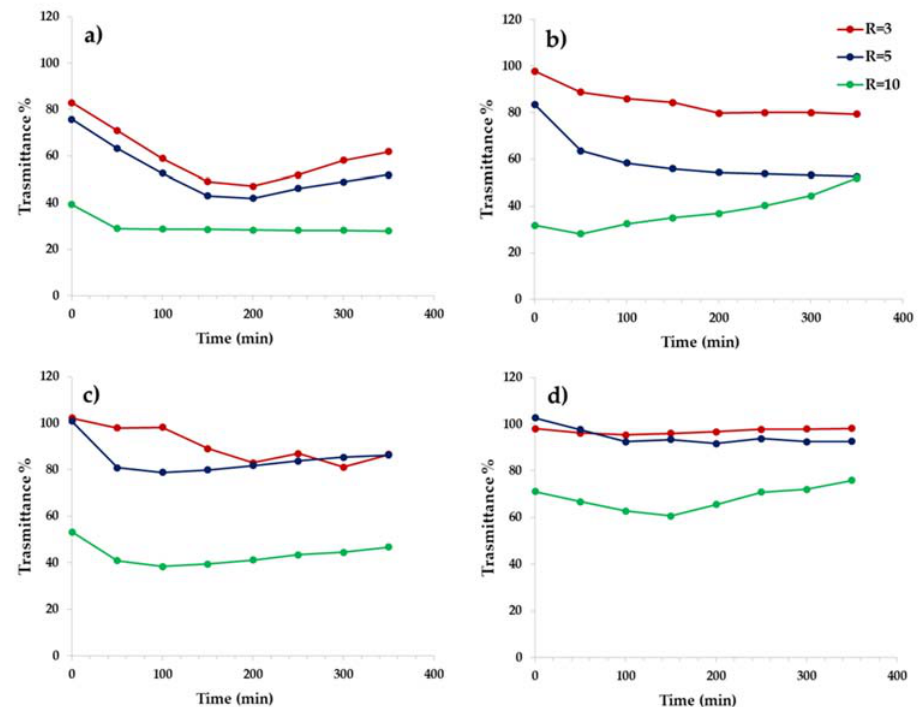
Figure 13. Turbidimetric analysis. Trasmittance at 500 nm of a dispersion containing mucin in the presence of polyplexes between siRNA and: ( a ) PHEA ‐ g ‐ bAPAE; ( b ) PHEA ‐ g ‐ PEG(A) ‐ g ‐ bAPAE; ( c ) PHEA ‐ g ‐ PEG(B) ‐ g ‐ bAPAE; ( d ) PHEA ‐ g ‐ PEG(C) ‐ g ‐ bAPAE graft copolymers, at R equal to 3, 5, and 10.